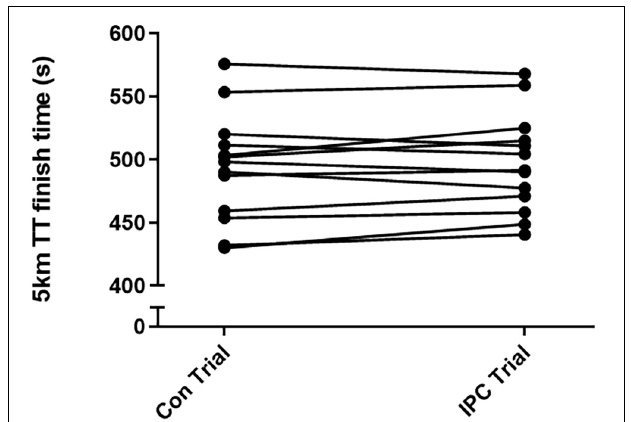
FIGURE 4 | Individual finish times in seconds of the 5-km time trial under normal conditions (Con trial) and following IPC (IPC trial). Of 13 participants, 8 improved exercise performance following IPC while 5 did not.